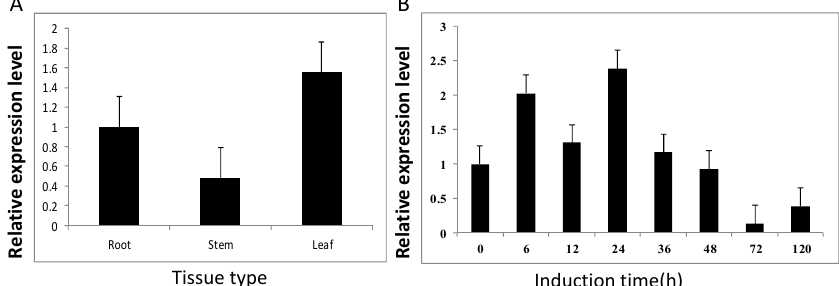
Figure 4. ( A ) Expression pattern of SmIPI1 in different S. miltiorrhiza tissues; ( B ) Expression profile of SmIPI1 after treatment with 30 mM Ag + over 120 h. The vertical bars show the SD values ( n = 3).